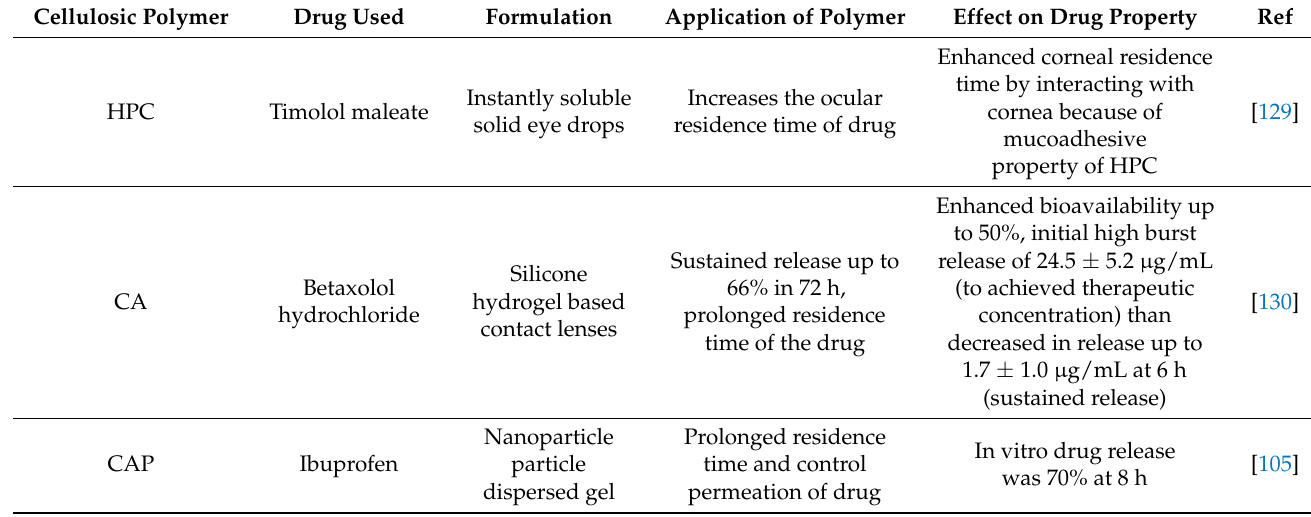
Table 11. Application of HPC, CA, and CAP in ocular drug